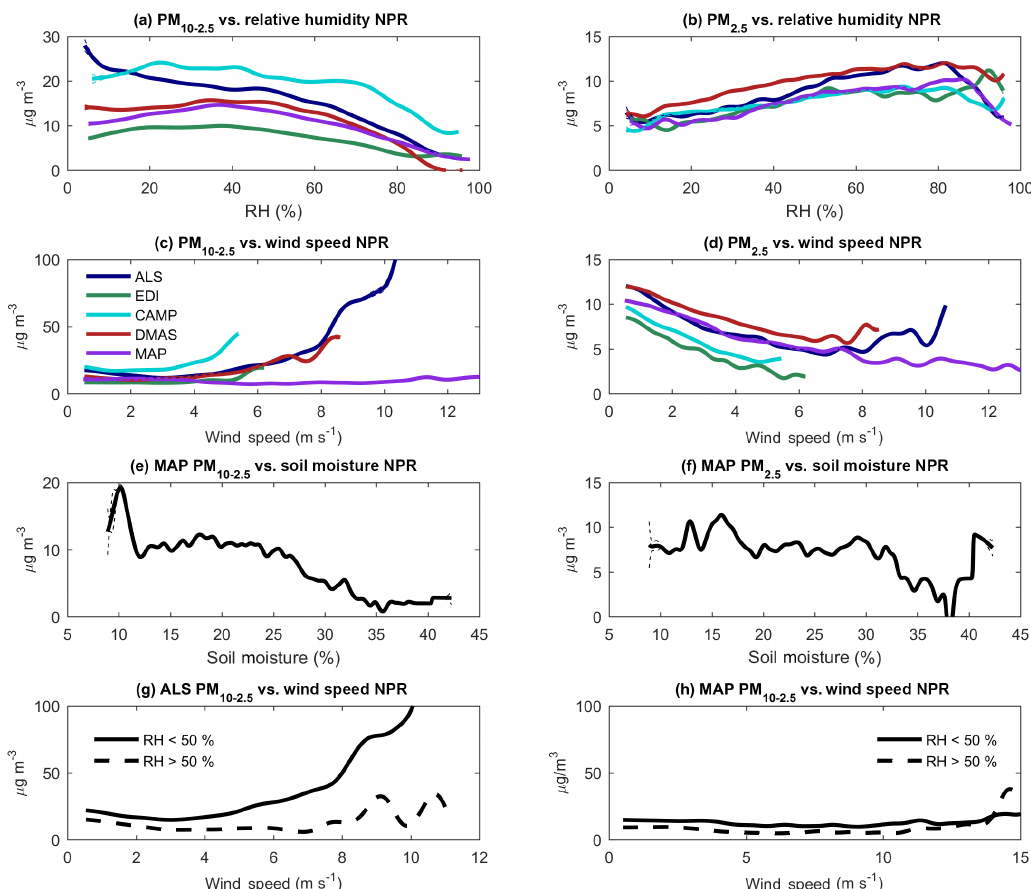
Figure 3. Expected value of pollutant concentrations (dashed lines are 95% confidence intervals) based on nonparametric regression (NPR) of: (a) PM 10 − 2 . 5 versus RH; (b) PM 2 . 5 versus RH; (c) PM 10 − 2 . 5 versus wind speed; (d) PM 2 . 5 versus wind speed; (e) MAP PM 10 − 2 . 5 versus soil moisture; (f) MAP PM 2 . 5 versus soil moisture; (g) ALS PM 10 − 2 . 5 versus wind speed with data stratified at 50% RH; and (h) MAP PM 10 − 2 . 5 versus wind speed with data stratified at 50%